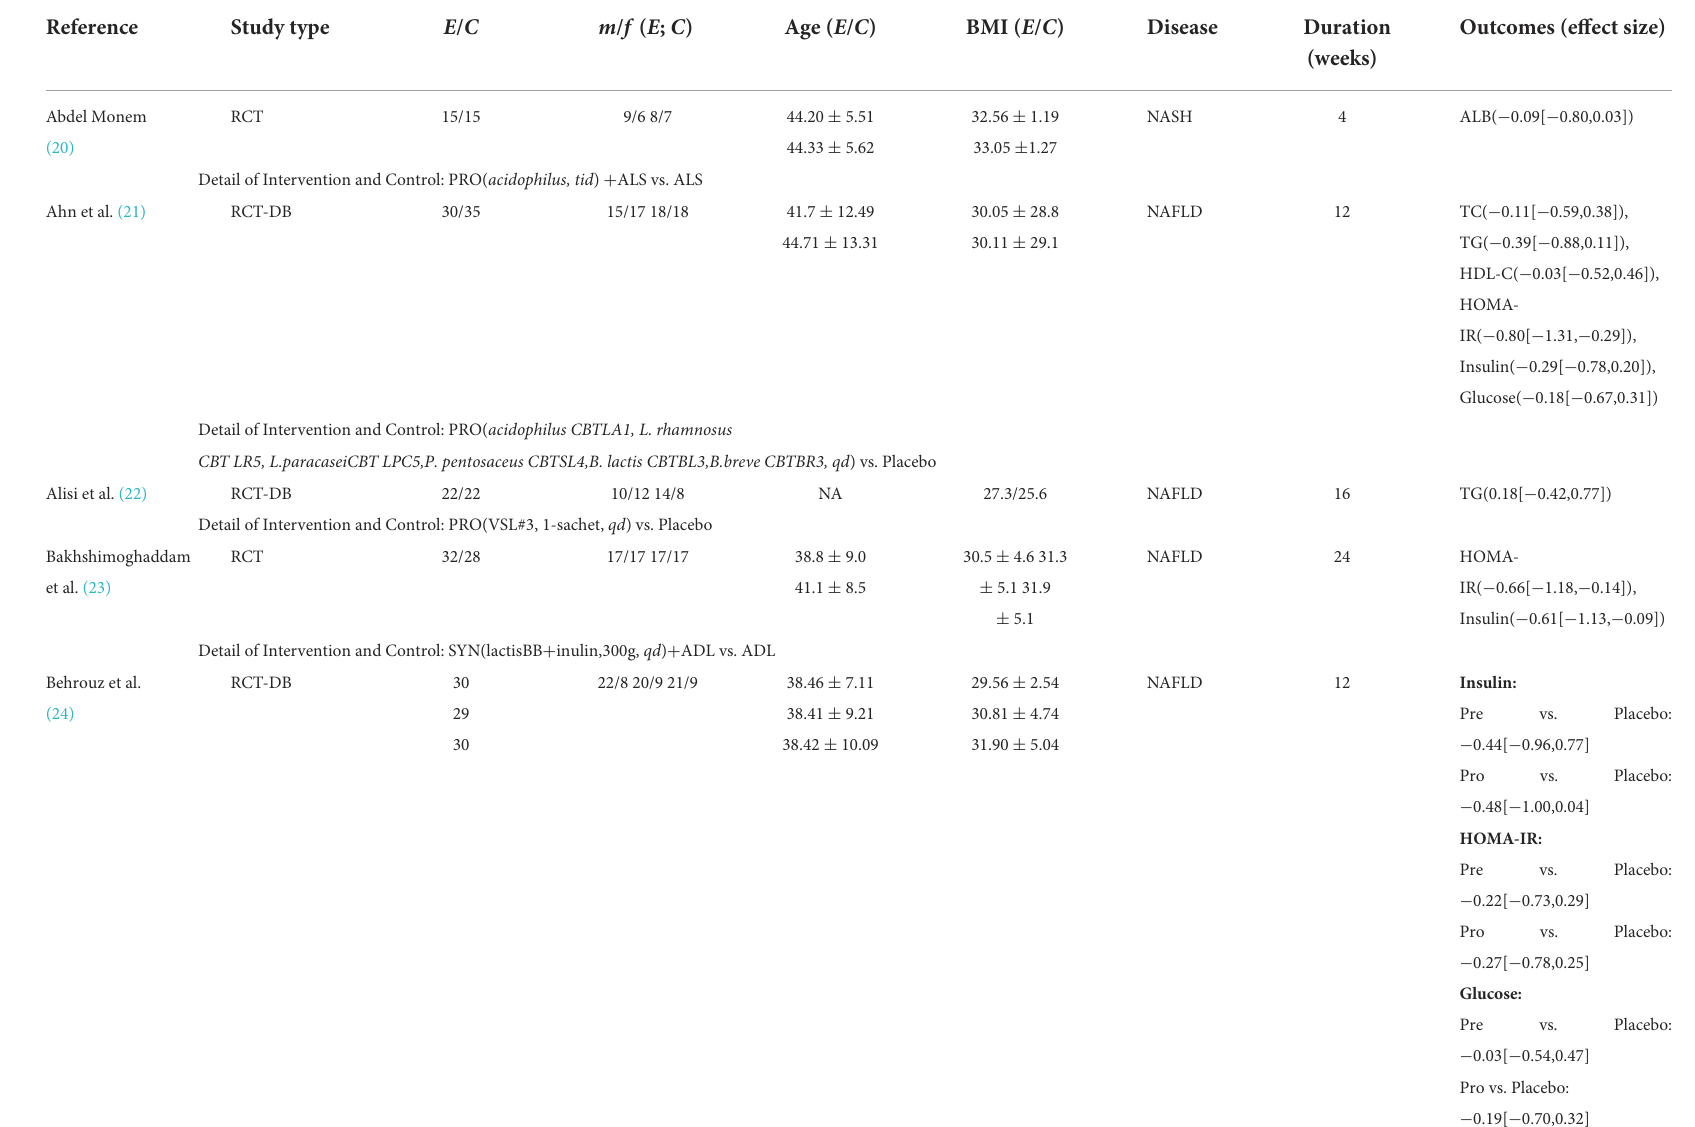
TABLE 1 Characteristics of the included